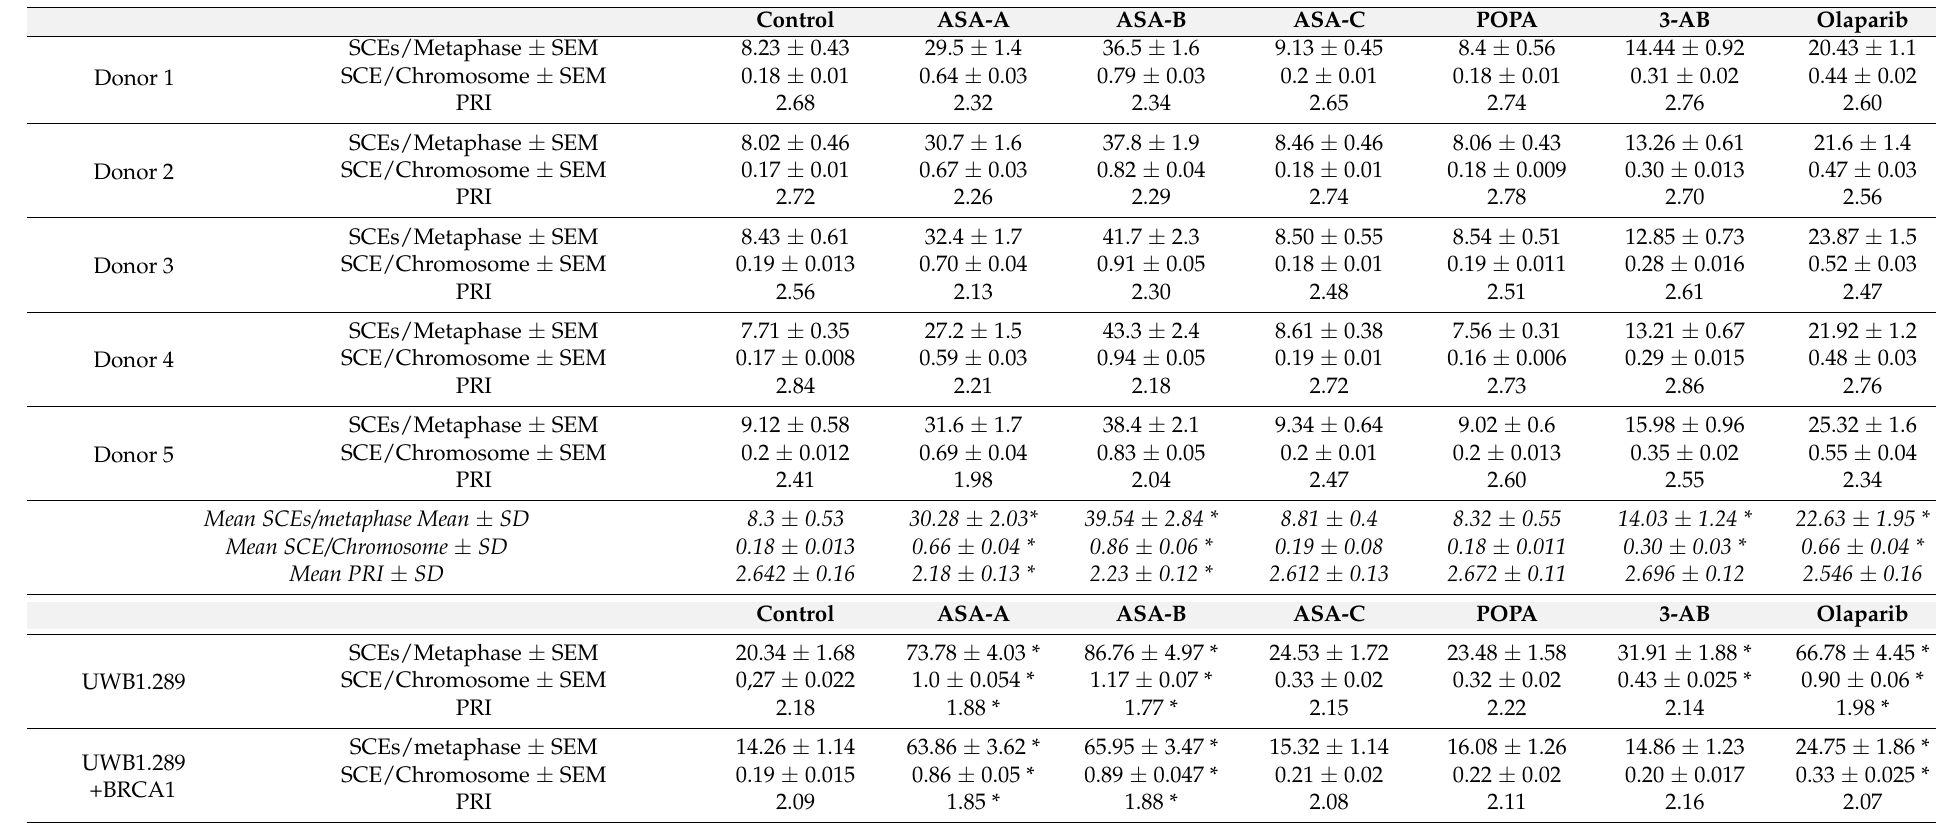
Table 5. Assessment of sister chromatid exchanges (SCEs) and respective PRIs induced in vitro by ASA-A, ASA-B, ASA-C, POPA, 3-AB and Olaparib at a drug concentration of 3 µ M in PHA-stimulated PBMCs obtained from 5 healthy donors, as well as in UWB1.289 and UWB1.289 + BRCA1 human ovarian cancer cell metaphases. * Significance level p < 0.01, compared to control values; two-side paired t